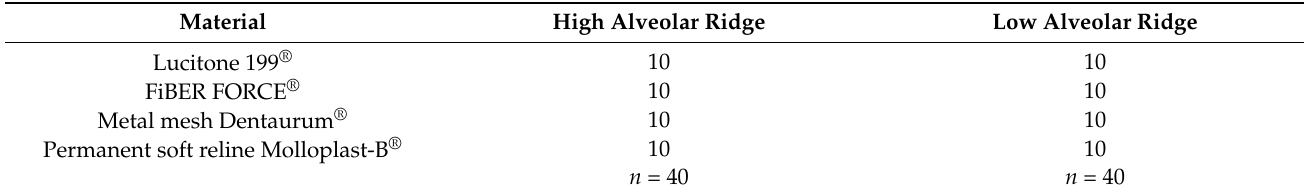
Figure 5. Cobalt–chromium spacer.